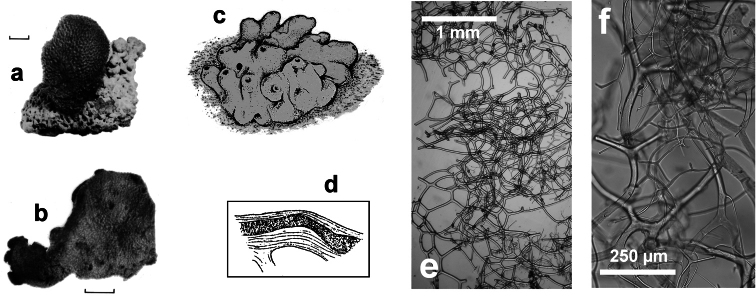
Spongia nitens. a, b dry specimens of the Schmidt’s collection preserved in the Landes Museum Joanneum of Graz c drawing of a living specimen d fibre showing an opaque narrow core e, f different magnification (LM) of the skeletal network, entirely free of mineral inclusions. a, b modified from Desqueyroux-Faundez and Stone (1992)
c, d modified from Vacelet (1987)
a, b scale bars = 1 cm.